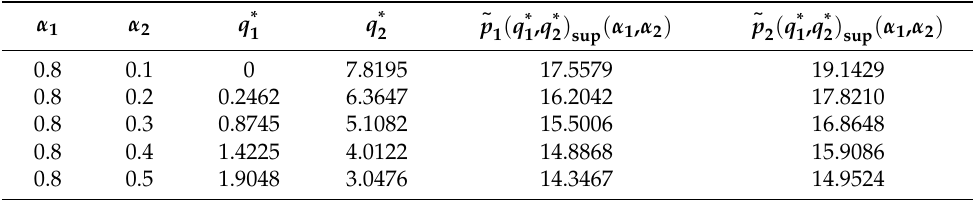
( α 1 , α 2 )-optimistic equilibrium quantity for Scenario III when AG’s risk aversion levels increase.